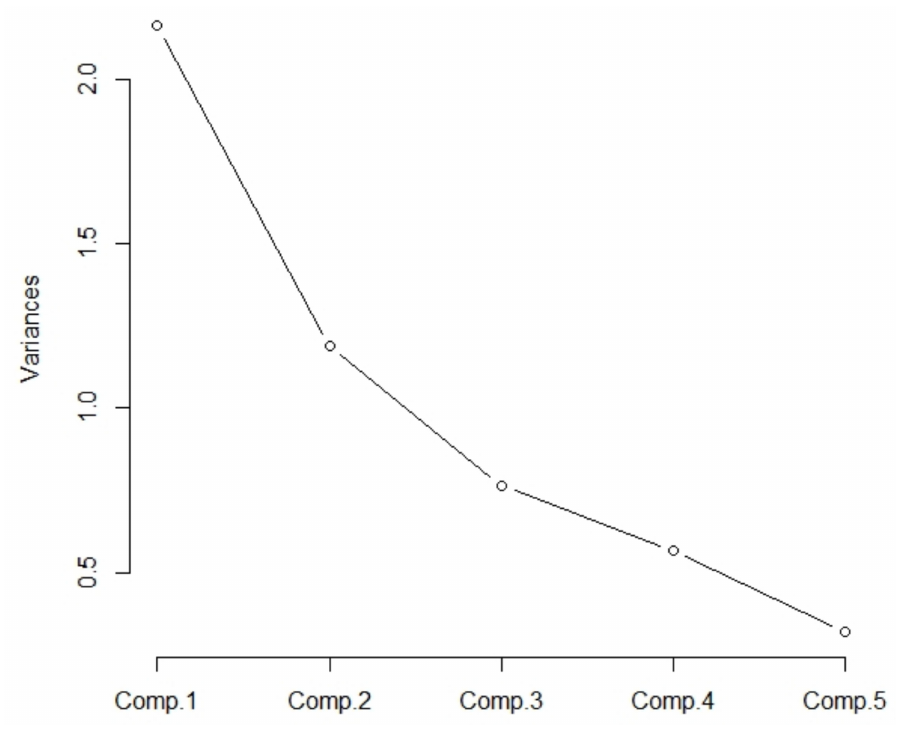
Figure 2. Eigenvalues of the correlation matrix R ν . Table 4. The PCA results calculated using the R program are as follows. Importance of